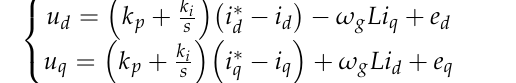
Figure 2. The overall marine renewable energy extraction chain.